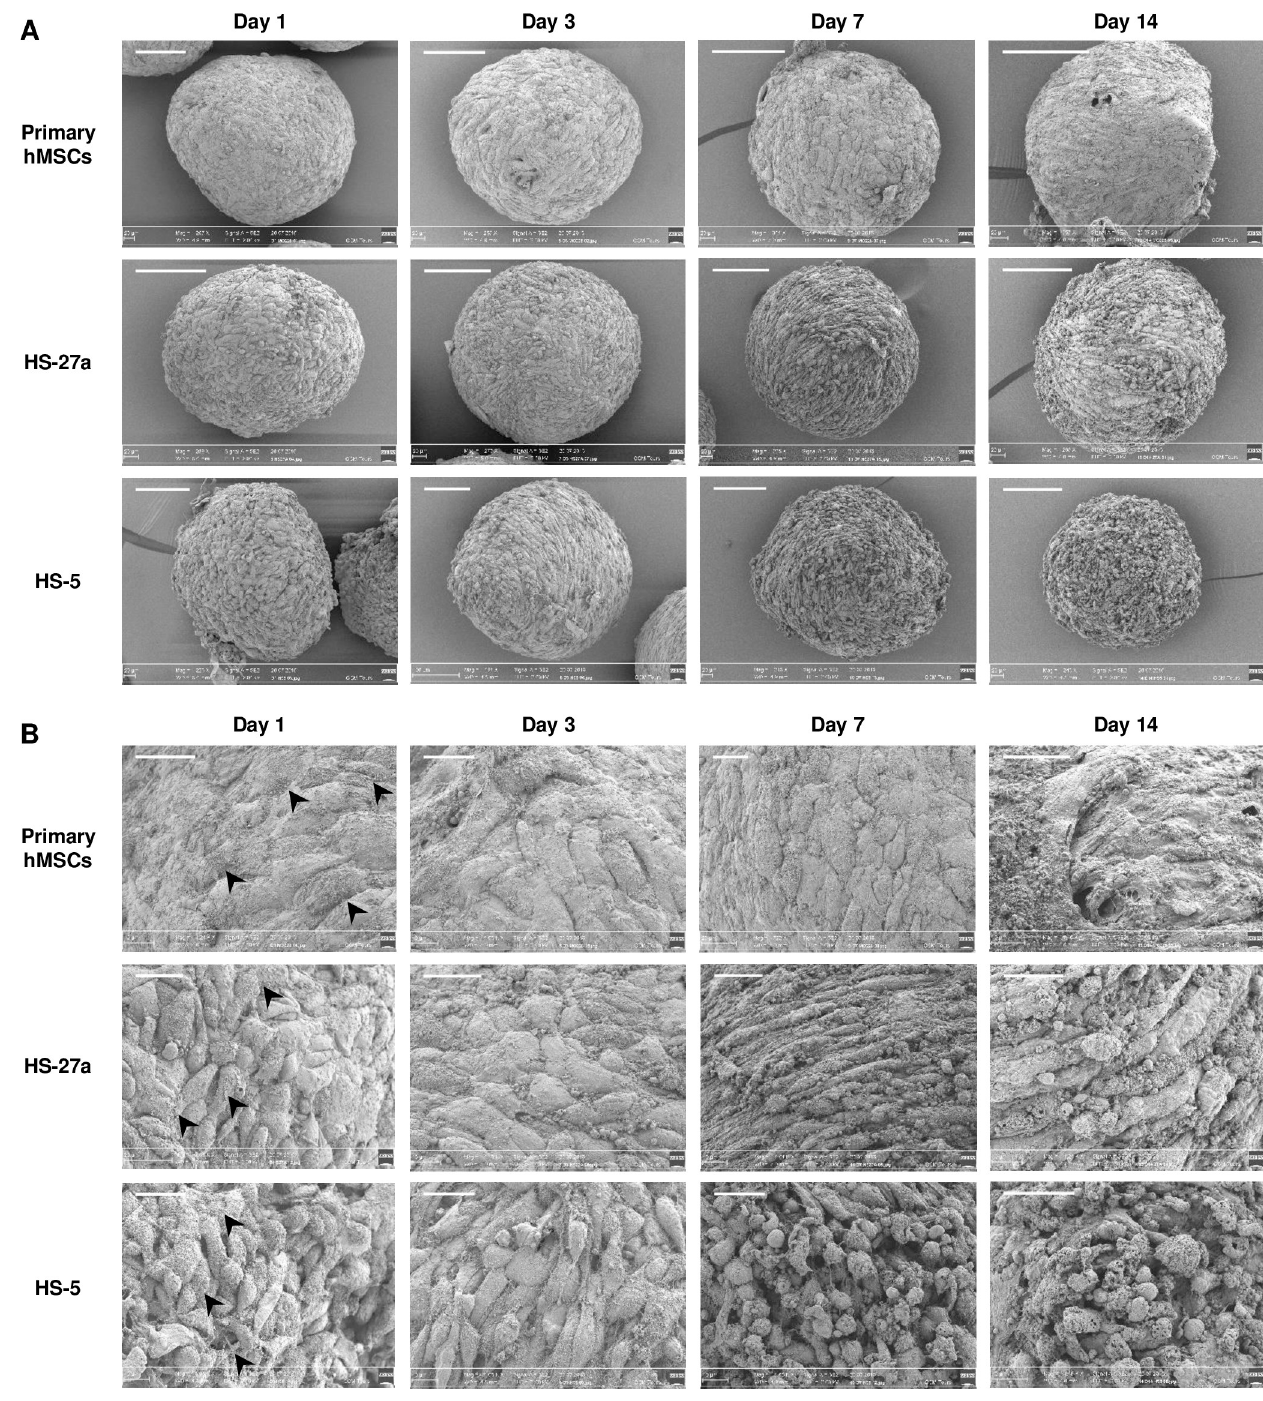
Fig 3. Scanning electron microscopy (SEM) observation of MSC-spheroids. (A) Spheroids from primary hMSCs are round with a smooth surface and show progressive shrinking. HS-27a- and HS-5-spheroids are more irregular and granular. (B) Higher magnification show that cells are cohesive at the surface of primary hMSC-spheroids and more chaotic with distinguishable cells of different shapes for human cell lines. ECM deposition (arrow heads) is visible on all spheroids. Scale bars = 100 μ m (A) and 20 μ m (B).